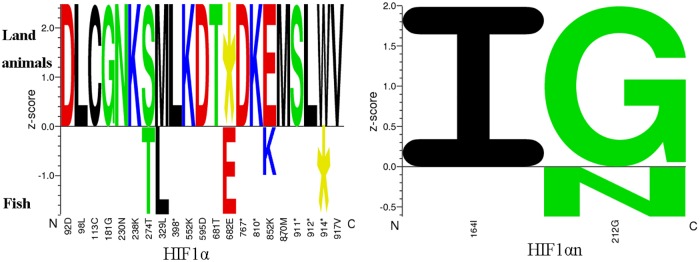
Sequence logo quantifying strength of residues in HIF1αn and HIF1α protein sequences that associated with traits between fishes and land animals.Amino acid residues on the positive y-axis are associated with strong land animal phenotype values and residues on the negative y-axis associated with fish phenotype values. The amino acids are colored according to their chemical properties as follows: Acidic [DE]: red, Basic [HKR]: blue, Hydrophobic [ACFILMPVW]: black and Neutral [GNQSTY]: green.